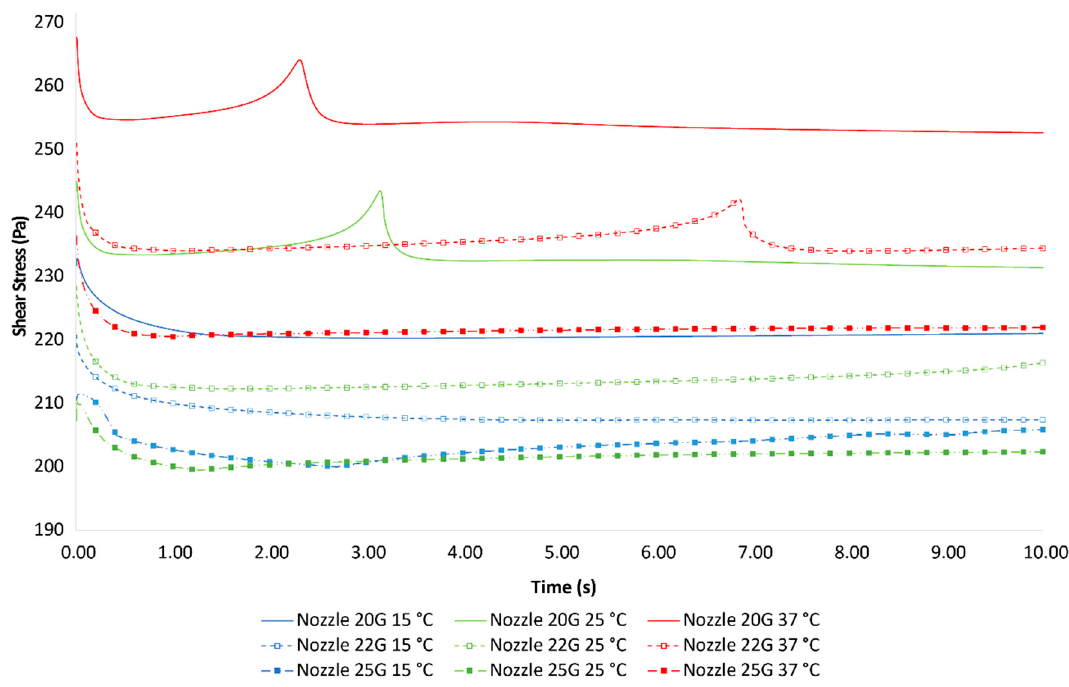
Figure 8. Maximum shear stress of 20, 22, and 25G conical tips using Cellink Bioink at 15, 25, and 37 °C.